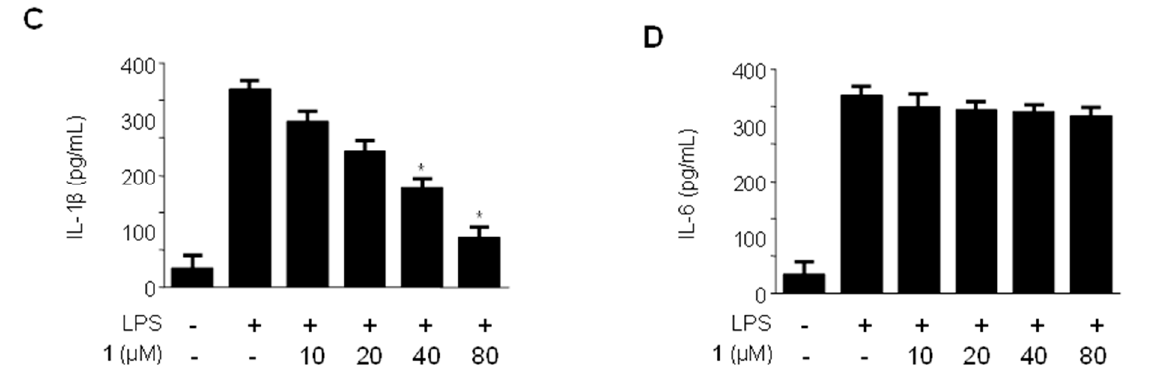
Figure 5. Effects of methylpenicinoline ( 1 ) on COX-2 ( A ) and iNOS ( B ) expression in RAW264.7 macrophages stimulated with LPS. Cells were pre-treated for 30 min with indicated concentrations of 1 and then for 24 h with LPS (500 ng/mL). Western blot analyses (A,B) were performed as described in described in Section 3.7; representative blots of three independent experiments are shown. Data are the mean values of three experiments ±